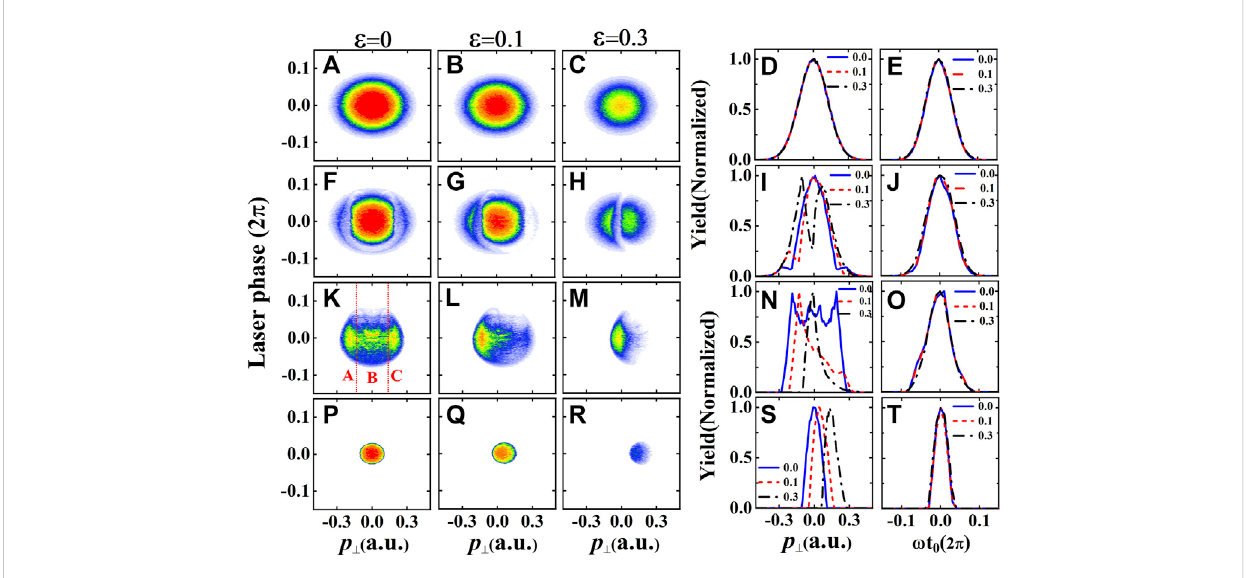
FIGURE 2 The laser phase dependence of the initial photoelectron transverse momentum distributions for tunneling (A – C) , ionization (F – H) and RSE (K – M), (P – R) processesattheellipticitiesof ε =0 (A,F,K,P) , ε =0.1 (B,G,L,Q) , ε =0.3 (C,H,M,R) .Theinitialphotoelectrontransversemomentumdistributionsin (D,I,N,S) andlaser phasedistributions in (E, J,O,T) areextracted from thedataof (A – C) , (F – H) , (K – M) and (P – R) , respectively. Thesedata arecalculated by the CTMC model with the laser intensity of 4×10 13 W/cm 2 and the wavelength of 800 nm. For the data in (P – R) , the Coulomb potential corrections of the photoelectron trajectories are ignored. Please fi nd more details in the